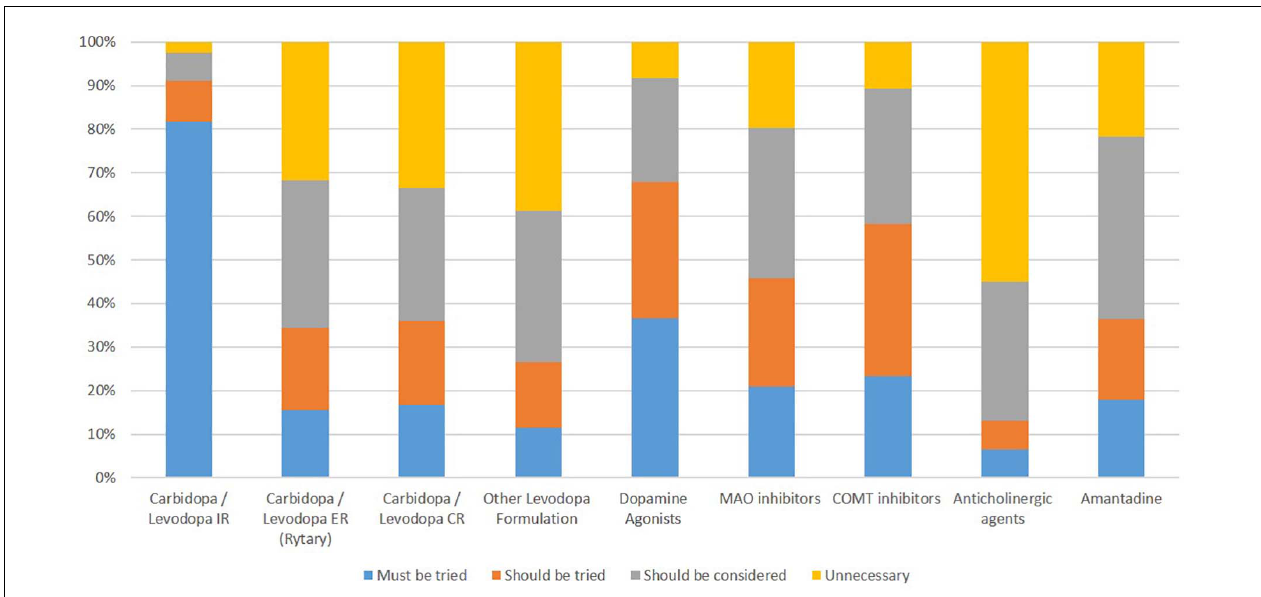
FIGURE 2 | Percentage of respondents reporting pharmacotherapy use prior to Deep Brain Stimulation for Parkinson’s